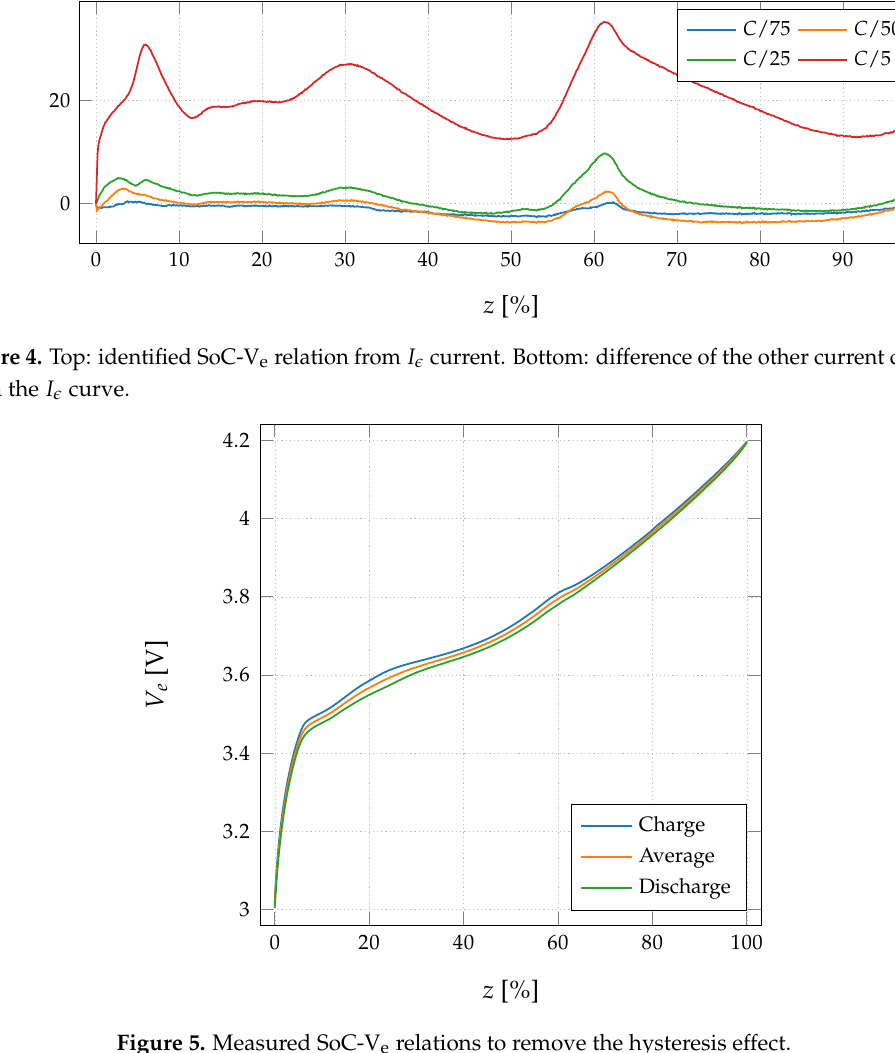
Figure 5. Measured SoC-V e relations to remove the hysteresis